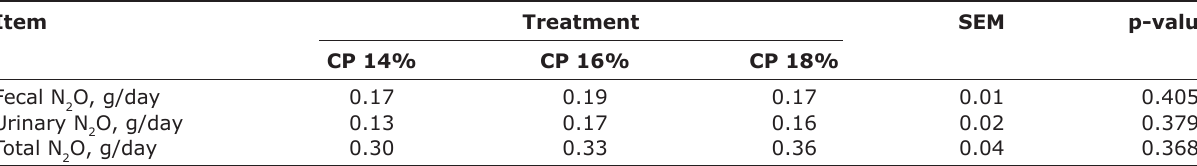
Table-5: Nitrous oxide emissions. Item